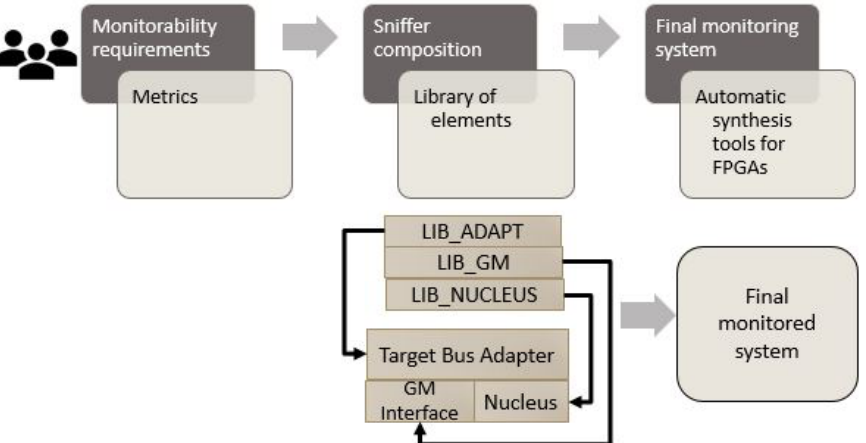
Figure 6. Monitoring system generation using AIPHS. Starting from some monitorability requirements, sniffers are composed taking elements from three libraries. Finally, the monitoring system is implemented as part of the whole system on